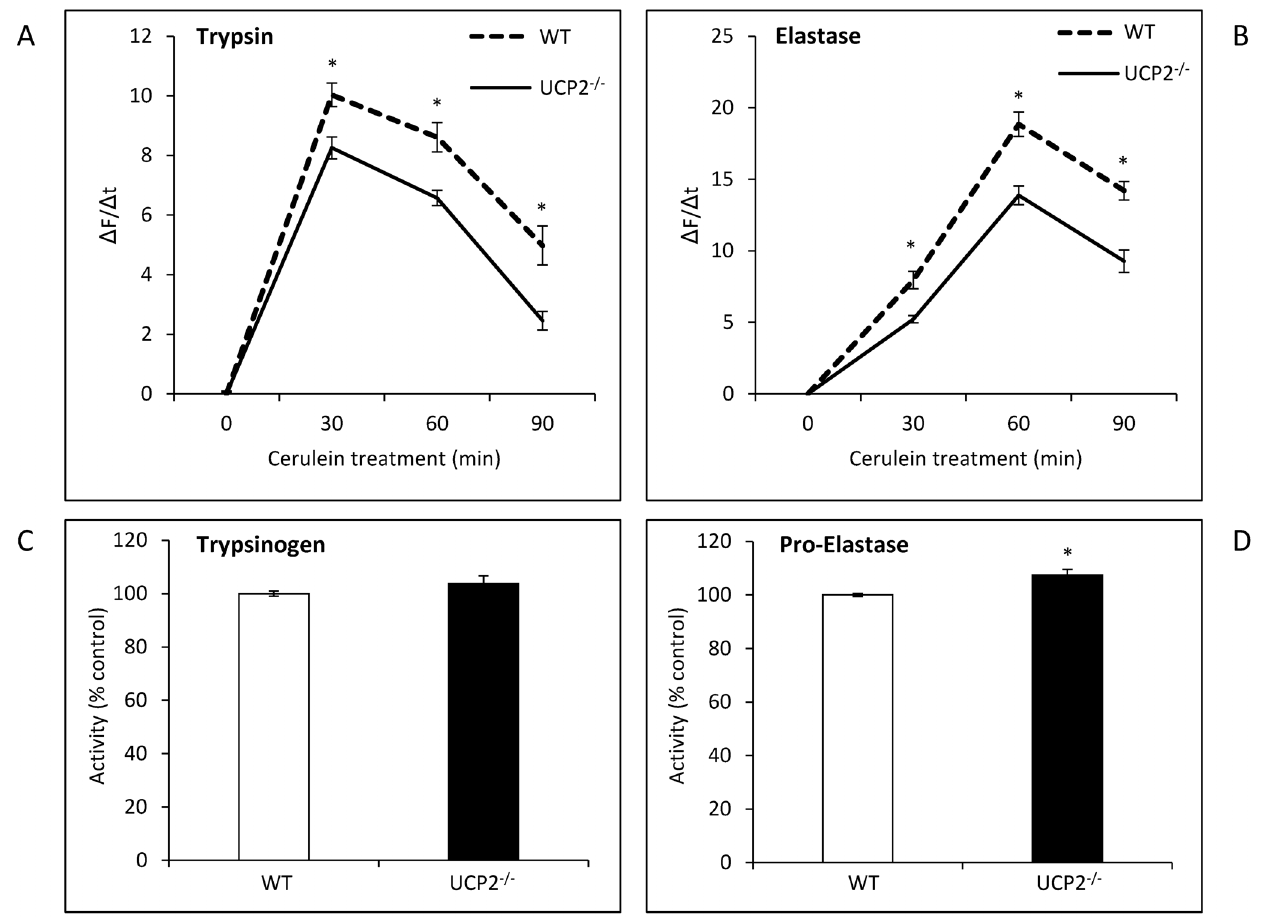
Figure 8. Trypsin and elastase activities in pancreatic acini isolated from WT and UCP2 -/- mice. Isolated pancreatic acini of 12 months old WT and UCP2 -/- mice were treated in vitro with cerulein (10 nmol/L) for up to 90 min. Subsequently, cleavage of rhodamine 110-labeled synthetic substrates for (A) trypsin and (B) elastase was recorded by cytofluorometry. To compare proteolytic activities, D F/ D t ratios were calculated and data expressed as ( D F/ D t) cerulein - ( D F/ D t) untreated (mean 6 SEM, n=36). * P , 0.05 (WT versus corresponding UCP2 -/- mice). The intracellular levels of trypsinogen (C) and proelastase (D) were assessed by incubating the lysates obtained from unstimulated WT- and UCP2 -/- cells of 12 months old mice with active trypsin as described in the ‘‘Materials and methods’’ section. A value of 100 percent corresponds to the averaged activity of in vitro - activated trypsin from WT cells. Data are shown as mean 6 SEM (n=18). * P , 0.05 (WT versus corresponding UCP2 -/- mice).